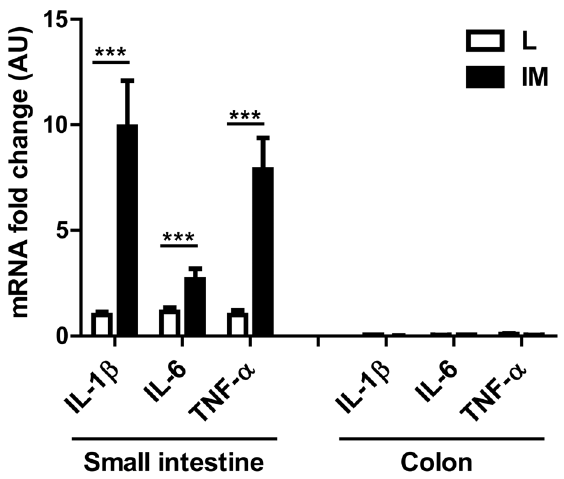
Figure 1. Intestinal manipulation triggers inflammation in the small intestinal muscularis but not in the colonic muscularis. Animals were sacrificed 24 after Laparotomy (L)/Intestinal Manipulation (IM). Mice undergoing L or IM display very low levels of IL-1 b , IL-6 and TNF- a in their colonic muscularis compared to the levels observed in the muscularis of the small intestine. IM leads to increased mRNA levels of pro-inflammatory cytokines IL-1 b , IL-6 and TNF- a in the small intestinal but not the colonic muscularis. Data shown are mean 6 SEM of 3 independent experiments (n=8–10 animals per group). ***p , 0.001 (Student t-test).